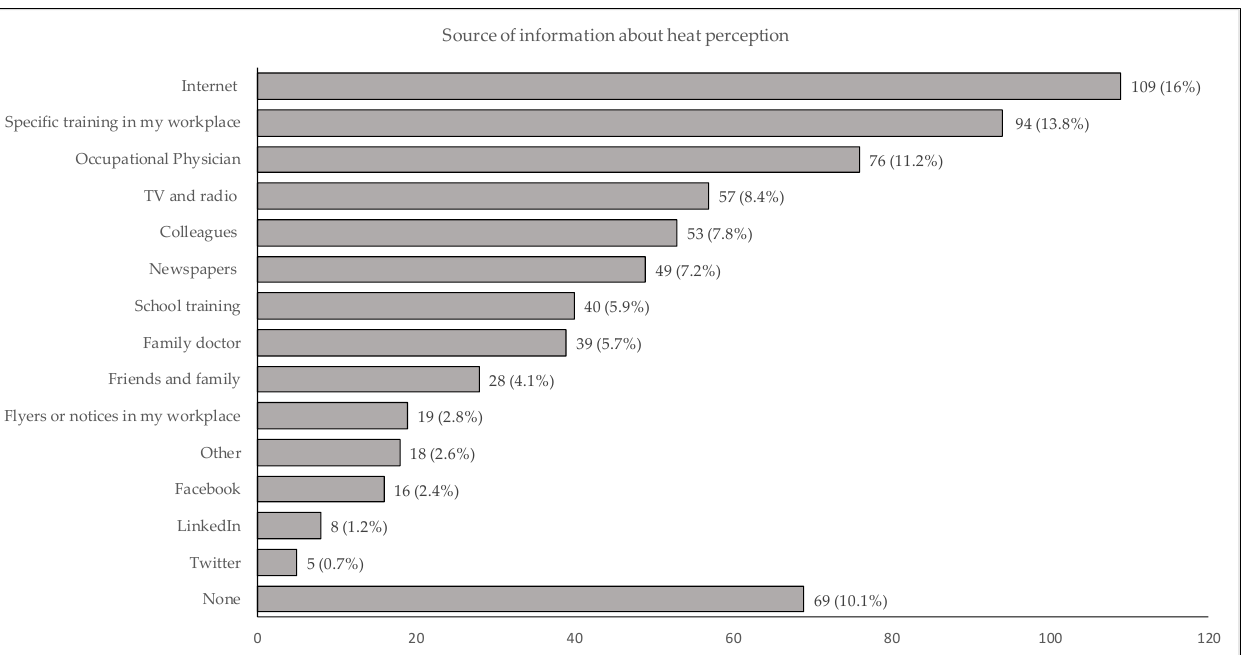
Fig 2. Frequencies and percentages of answers to the question 77 -What are your main sources of information Figure 2. Frequencies and percentages of answers to the question 77—What are your main sources of on the prevention of heat-related diseases in the workplace? (Multiple choice). information on the prevention of heat-related diseases in the workplace? (Multiple